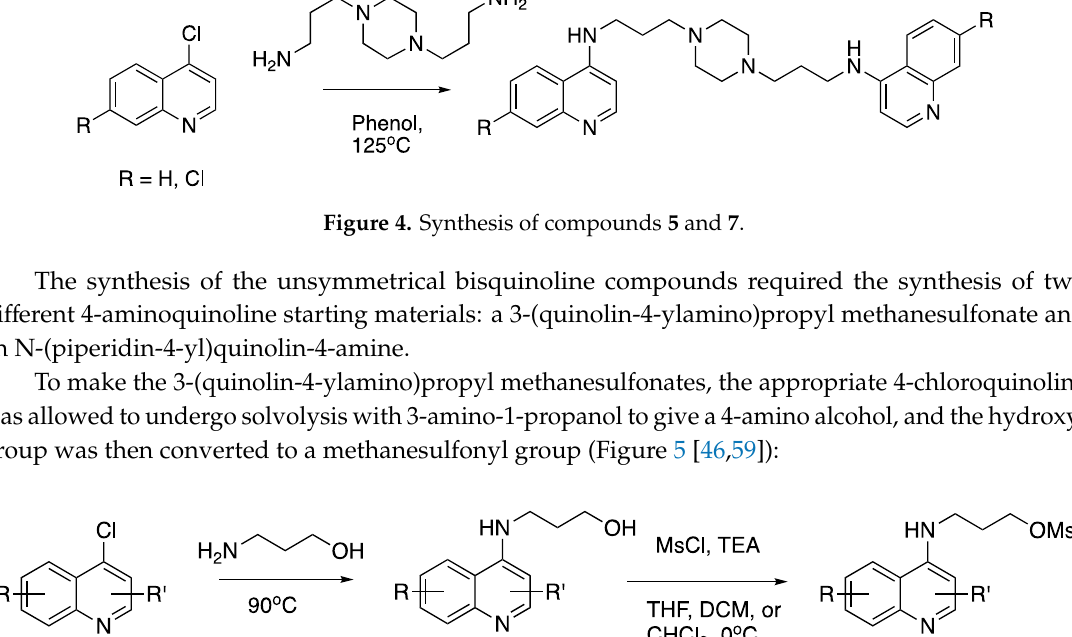
Figure 3. Synthesis of compound 1.